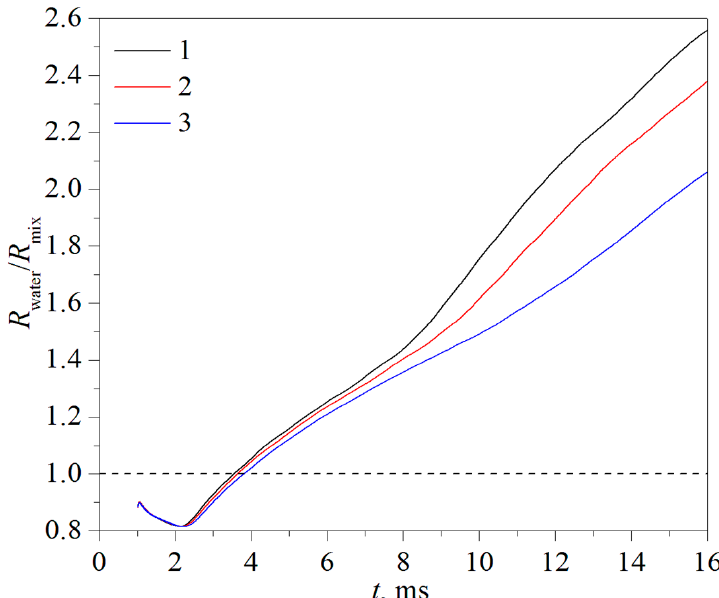
Figure 9. Change in the ratio of thermal resistance of a mixture containing 30 wt.% PPG-425 to the thermal resistance of water over time under specified heat release conditions (see Figure 8) at various pressure values: 1 (black line)—25 MPa; 2 (red line)—30 MPa; 3 (blue line)—40 MPa. The heat-transfer pattern at various heat flux density values is presented in Figure